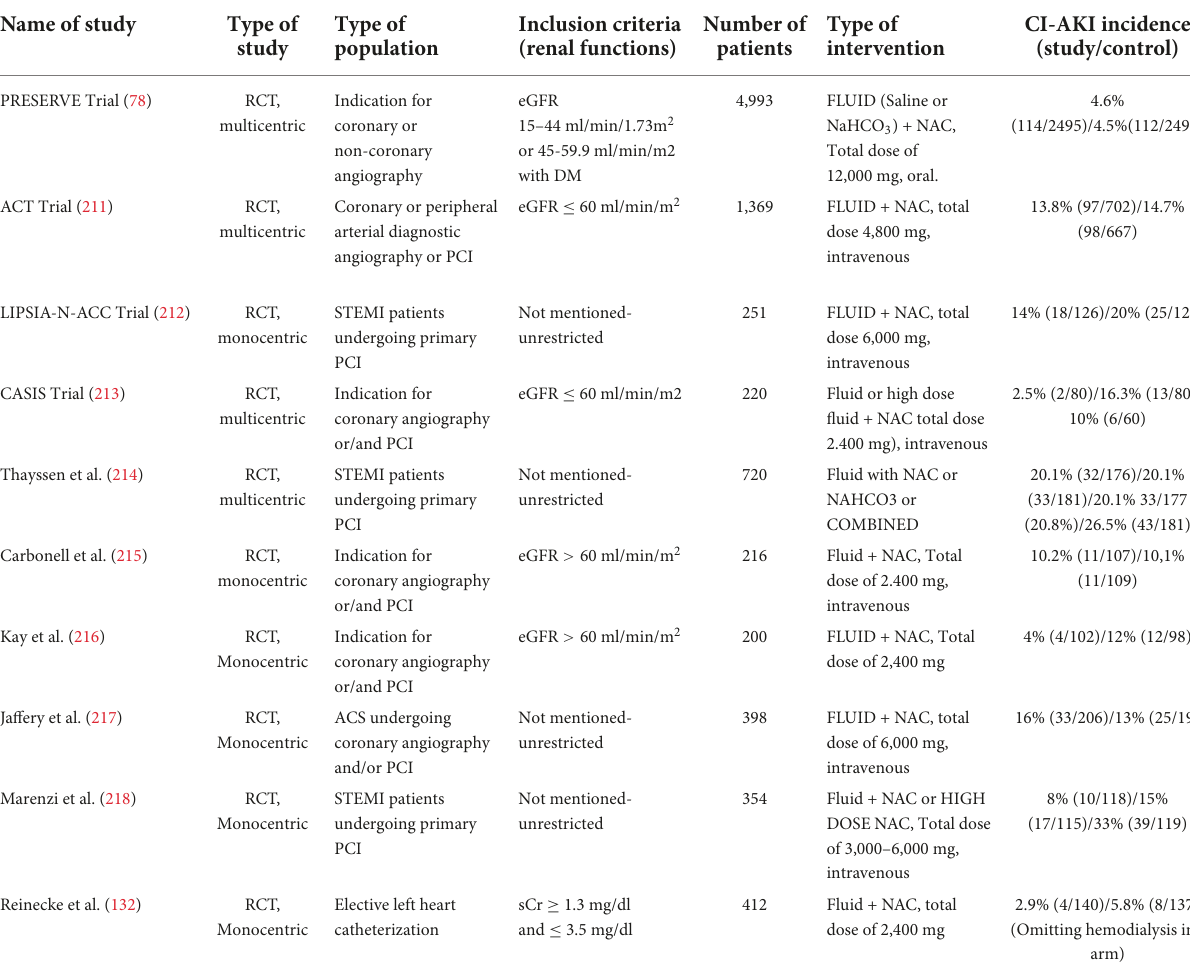
TABLE 7 RCT comparing N acetyl cysteine as prevention method of